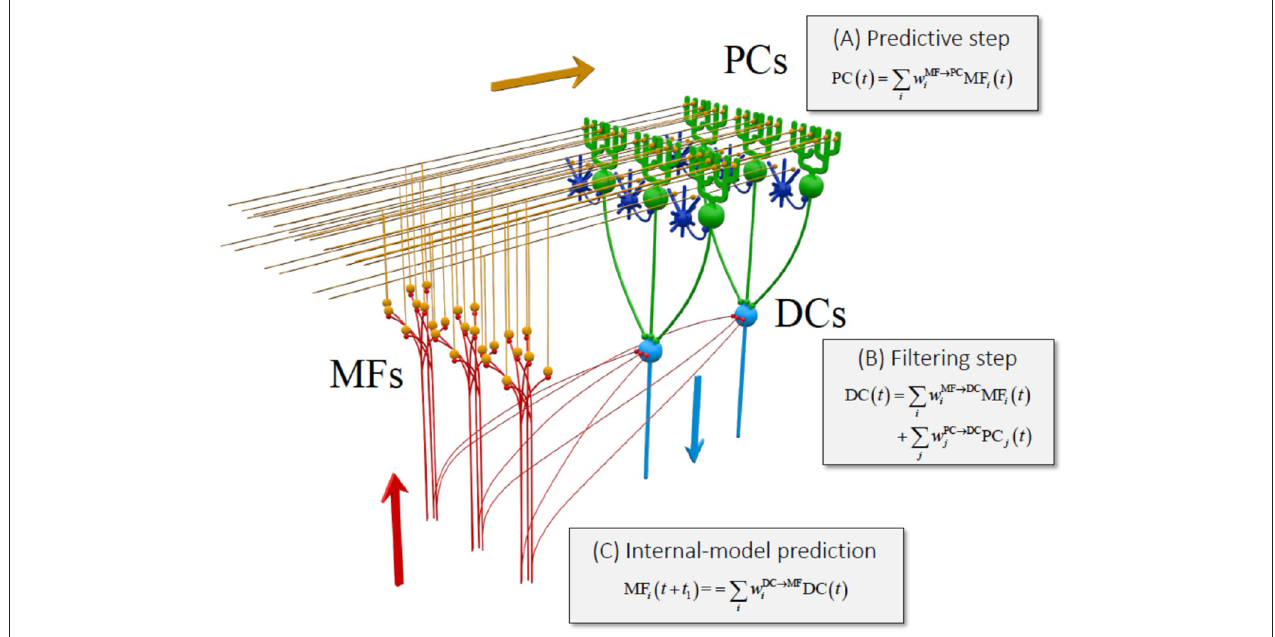
FIGURE 2 | Equivalence of the cerebrocerebellar circuitry to a Kalman filter [reproduced with permission from Tanaka et al. (63)]. Schematic of the Kalman filter model of the cerebrocerebellum overlaid on the cerebellar circuit. MF, mossy fiber (red); PC, Purkinje cell (green); DC, dentate cell (light blue). Granule cells (orange) and inhibitory interneurons (blue) that are not analyzed in this work are included to show the basic structure of the cerebellar neuron circuitry. Three stages of linear computation obtained in our analysis are accompanied with the three types of computation of Kalman filter explained in the text. Reproduced from Tanaka et al. (63) under CC-BY